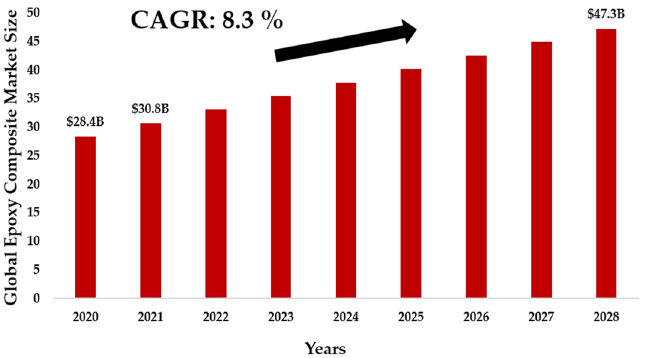
Figure 2. Epoxy Composites Market Size and Forecast. Authors’ own figure from Reference [19].